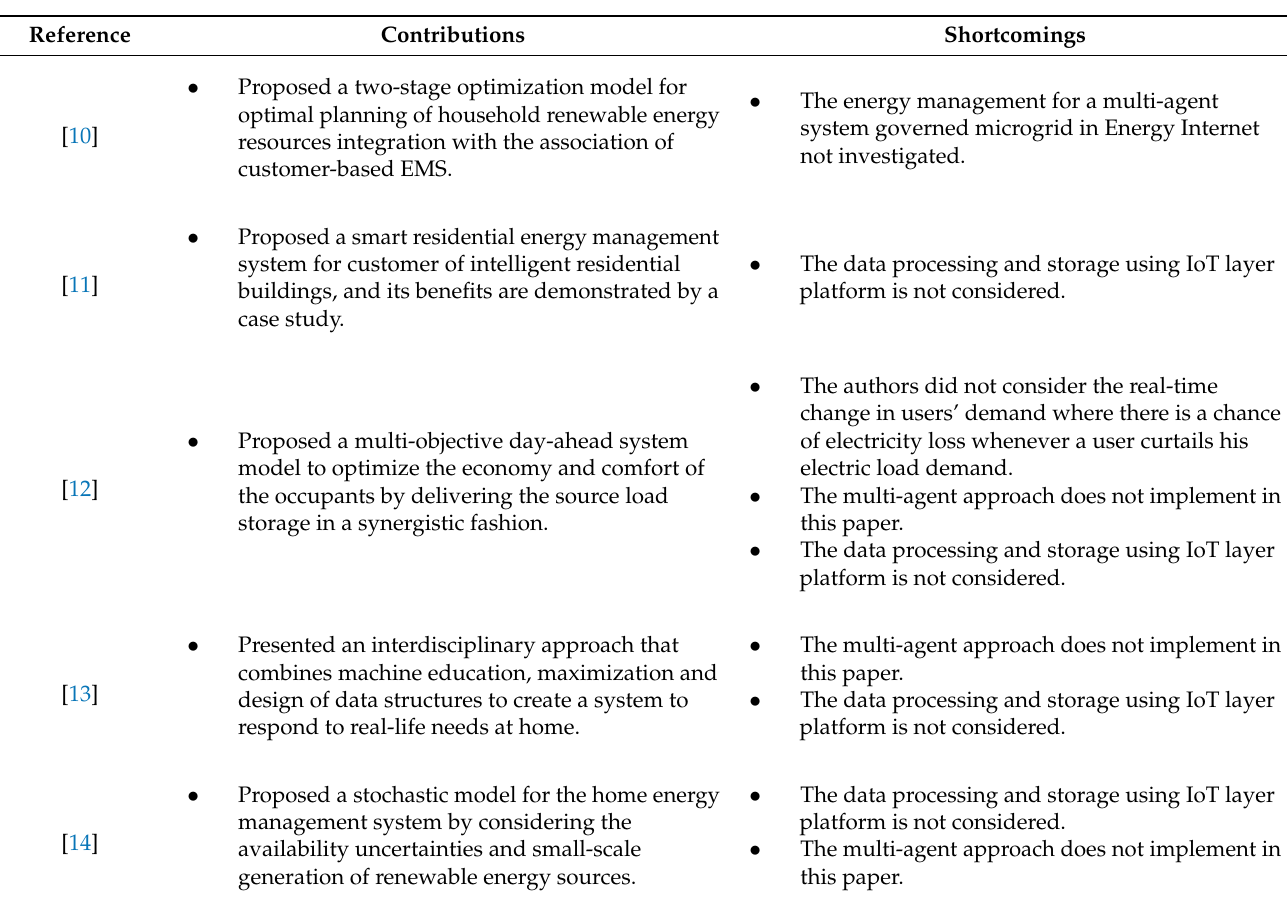
Table 2. Contributions versus shortcomings of the most recent papers concerning energy management system.